Question: Compose a caption that would accompany this figure in a paper.
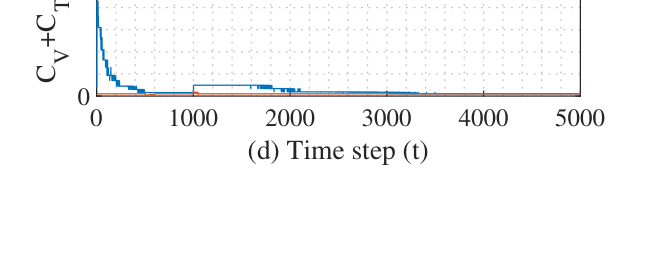
Answer: (a) The input request to each node. (b) The average regret of both methods. (b) The Euclidean distance between two consecutive probability distributions produced by Algorithm 1. (c) Reservation cost (C(At)) for each time slot t. (d) The blocking cost (C0(At, Bt)) .